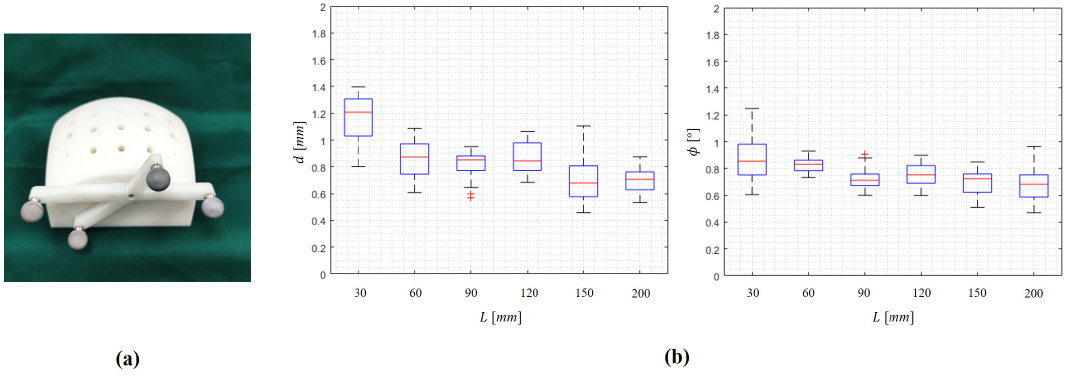
Figure 7. Investigation of the influence of the range of robot movement to the hand–eye calibra- tion: ( a ) the plastic phantom used in the experiment; ( b ) the box plots of distance deviation and incline angle. Table 2. Investigation of the influence of the range of robot movement to the hand–eye calibration. d [mm] φ [ ◦ ] L [mm] Mean Max.